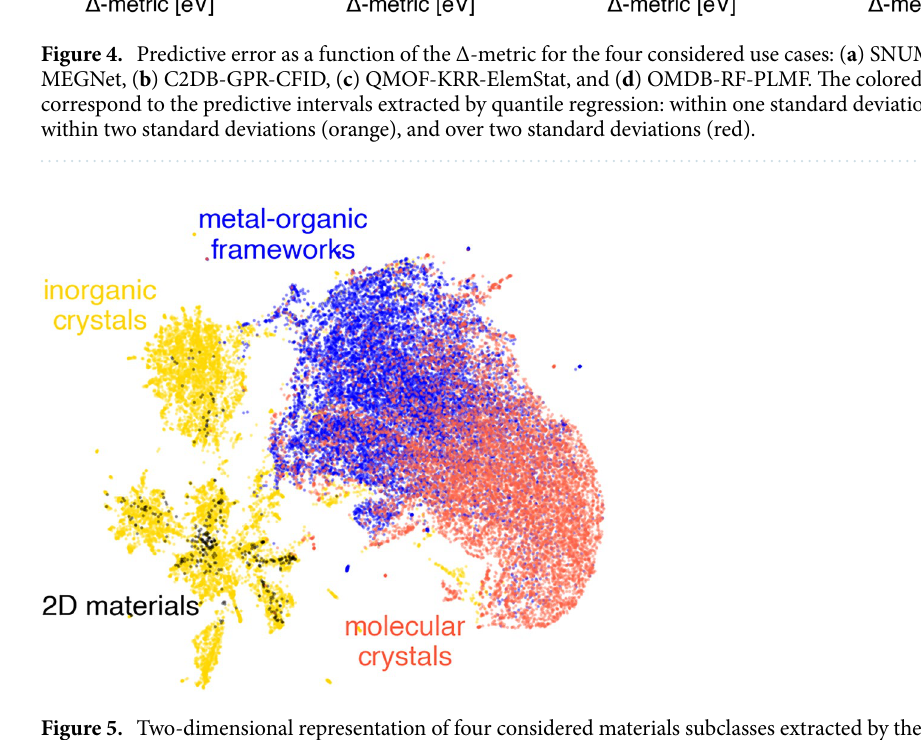
Figure 5. Two-dimensional representation of four considered materials subclasses extracted by the uniform manifold approximation and projection